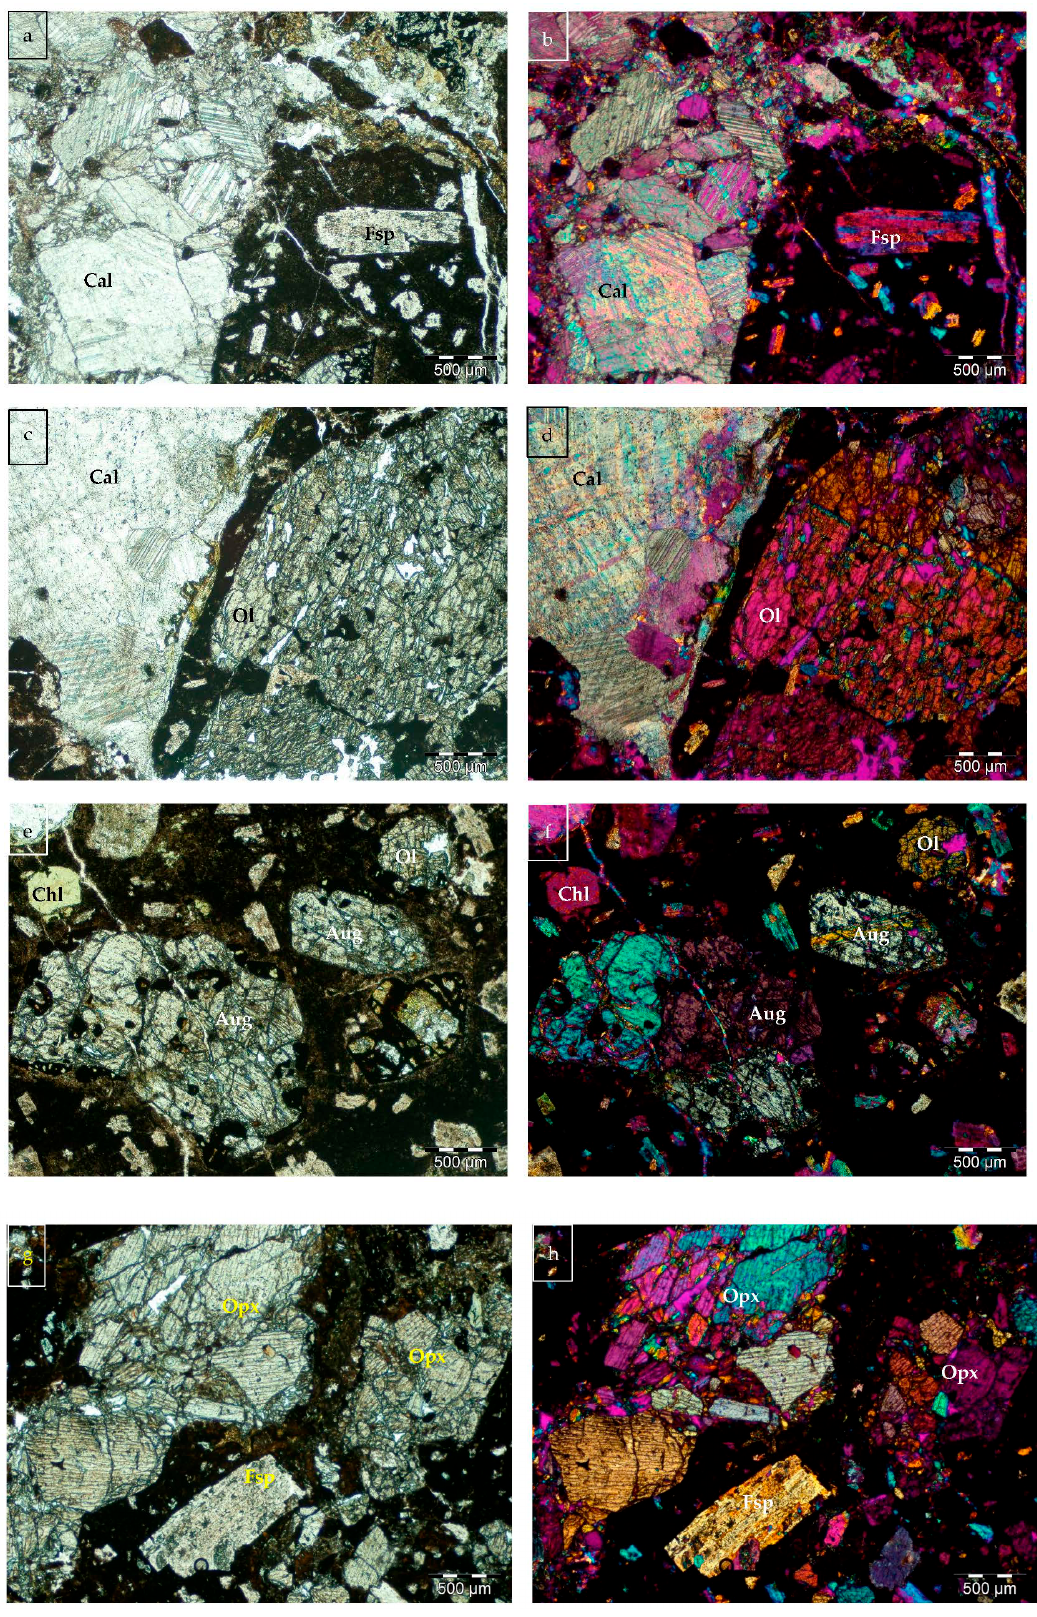
Figure 3. Petrography of Segamat basalt samples under PPL ( a , c , e , g ) and XPL ( b , d , f , h ) using 4 × magnification. Cal, Fsp, Ol, Chl, Aug, and Opx represent calcite, feldspar, olivine, chlorite, augite, and orthopyroxene,